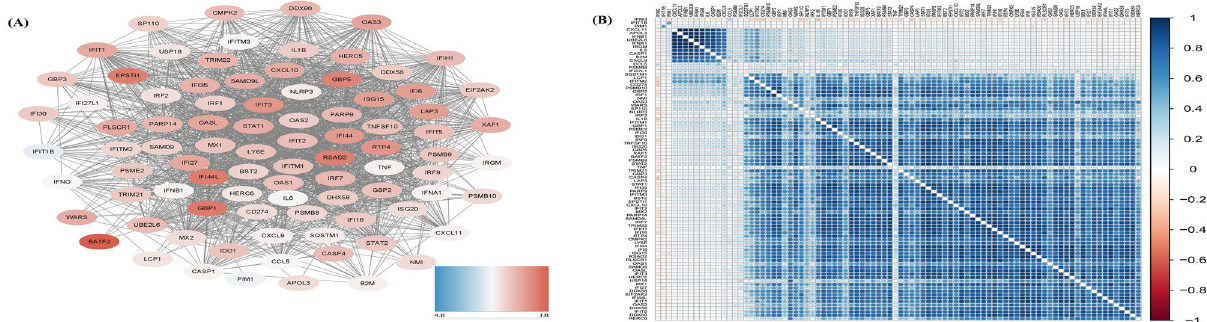
Figure 3. Network construction of GBP1 modular genes. ( A ) The PPI network construction of GBP1 and each modular genes based on the STRING database, red was up-regulated genes and blue was down -regulated genes, the value was adjusted by the false discovery rate (FDR). ( B ). The correlation between GBP1 and modular genes, red indicates negative correlation and blue indicates positive